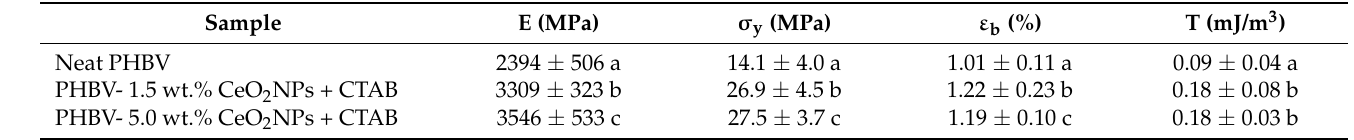
Table 4. Mechanical characterization of the electrospun poly(3-hydroxybutyrate-co-3-hy- droxyvalerate) (PHBV) films loaded with cerium oxide nanoparticles (CeO 2 NPs) and hexadecyltri- methylammonium bromide (CTAB) based on tensile modulus (E), tensile strength at yield ( σ y ), elon- gation at break ( ε b ), and toughness (T).